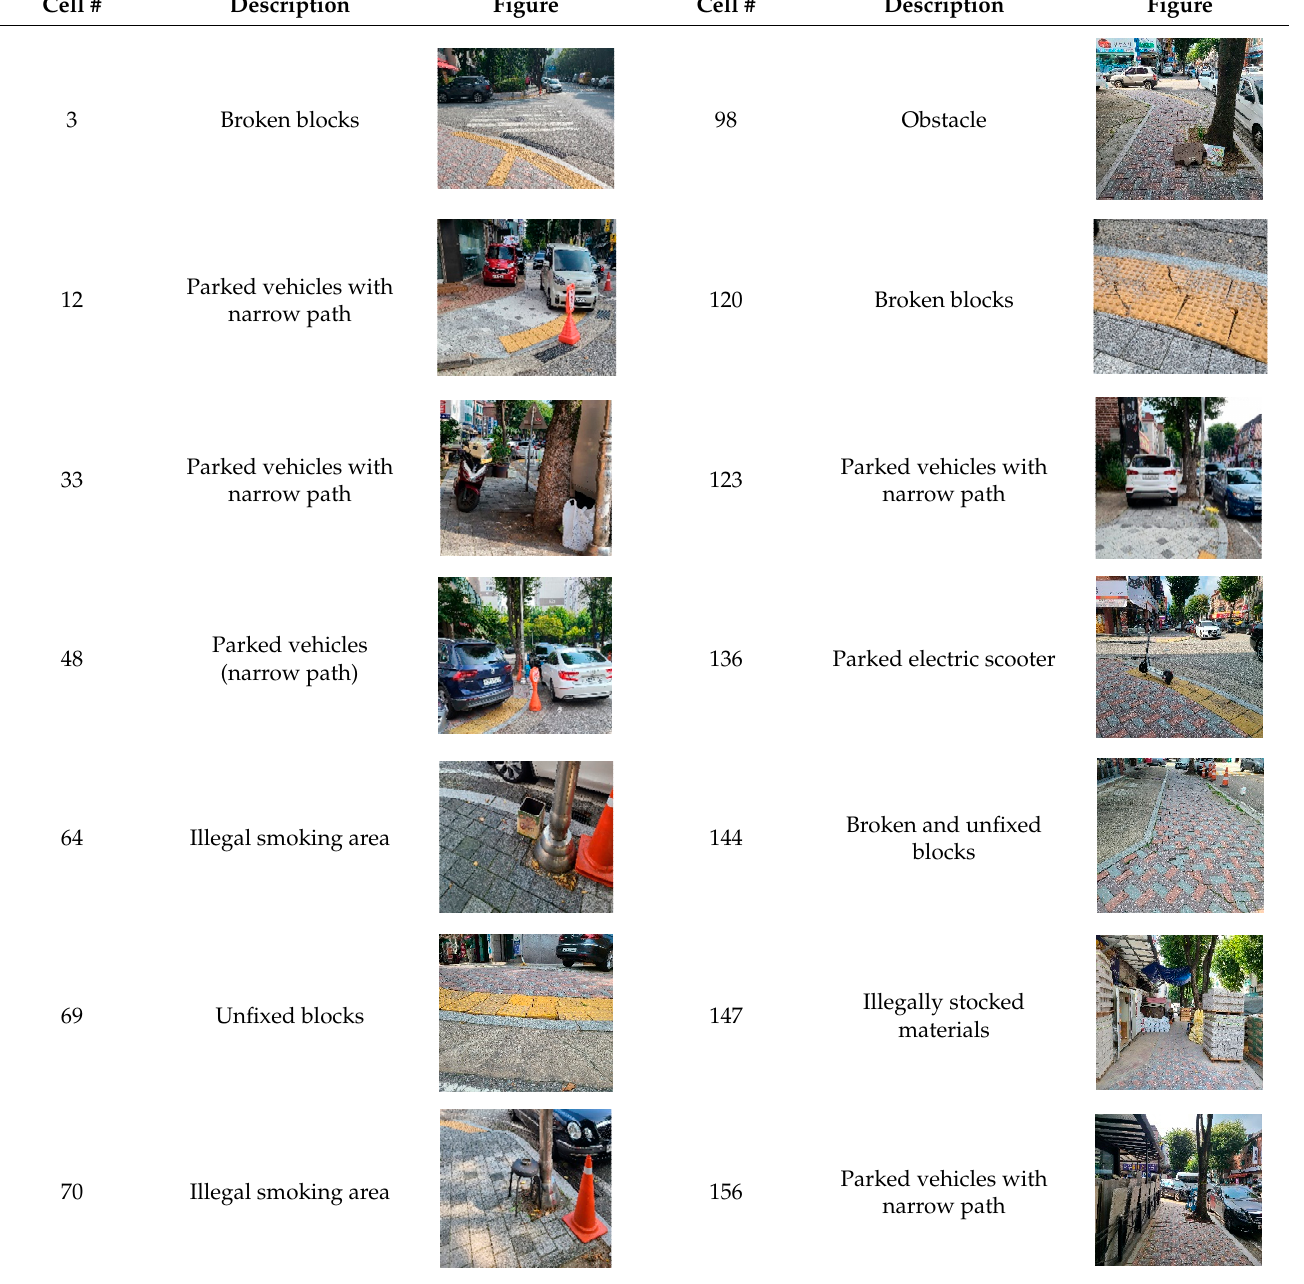
Table 2. Environmental barriers at the experimental site.